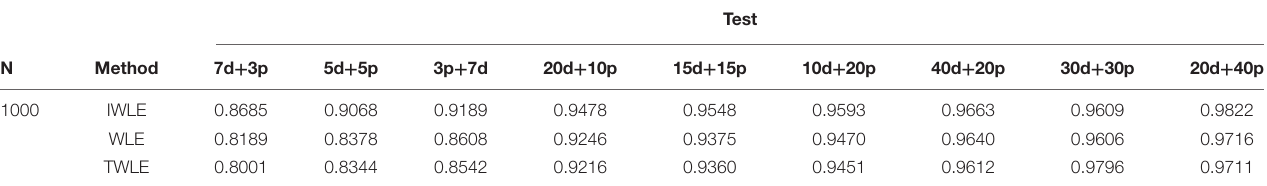
FIGURE 2 | Weights based on θ ( θ = (θ 1 ,θ 2 )) at 17 ability levels for dichotomous items (item 1 to 6) and polytomous items (items 7 to 9) in test 2. TABLE 1 | Correlation between the estimated abilities and the true abilities for all three weighting estimation methods under nine conditions.